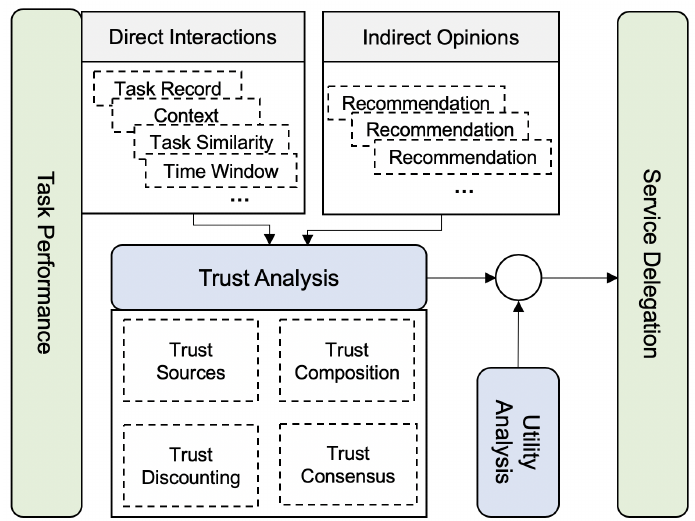
Figure 2. The design framework of the trust model and service